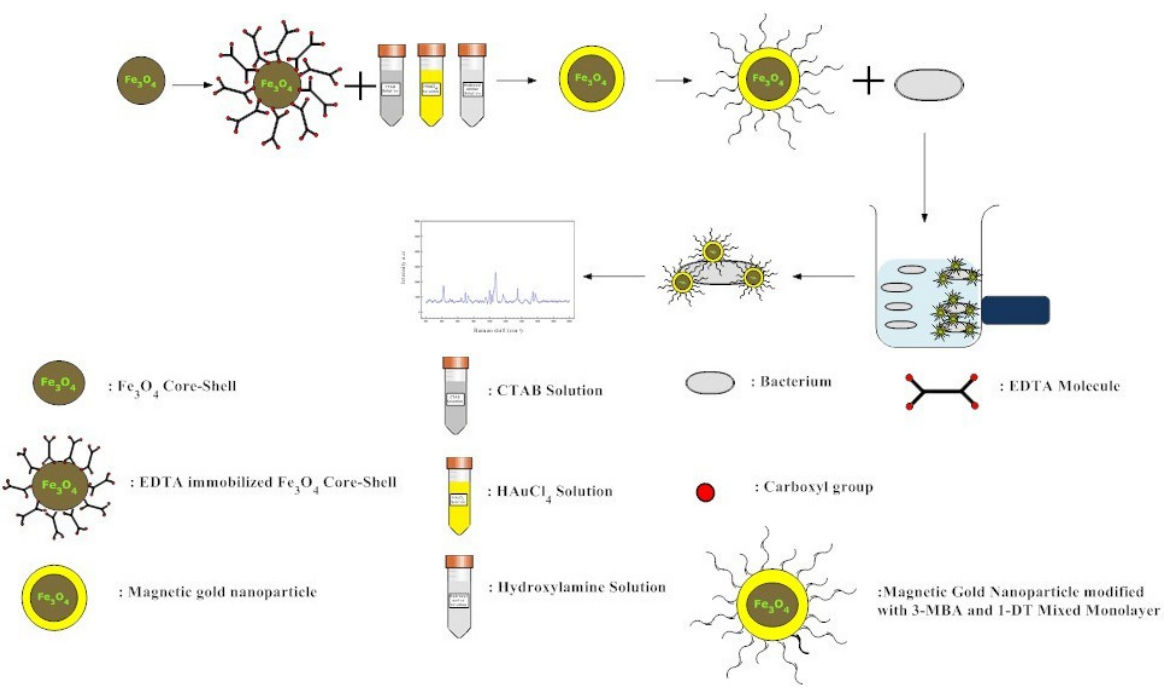
Scheme 1. Schematic illustration of the surface modification of magnetic gold nanoparticles and E. coli